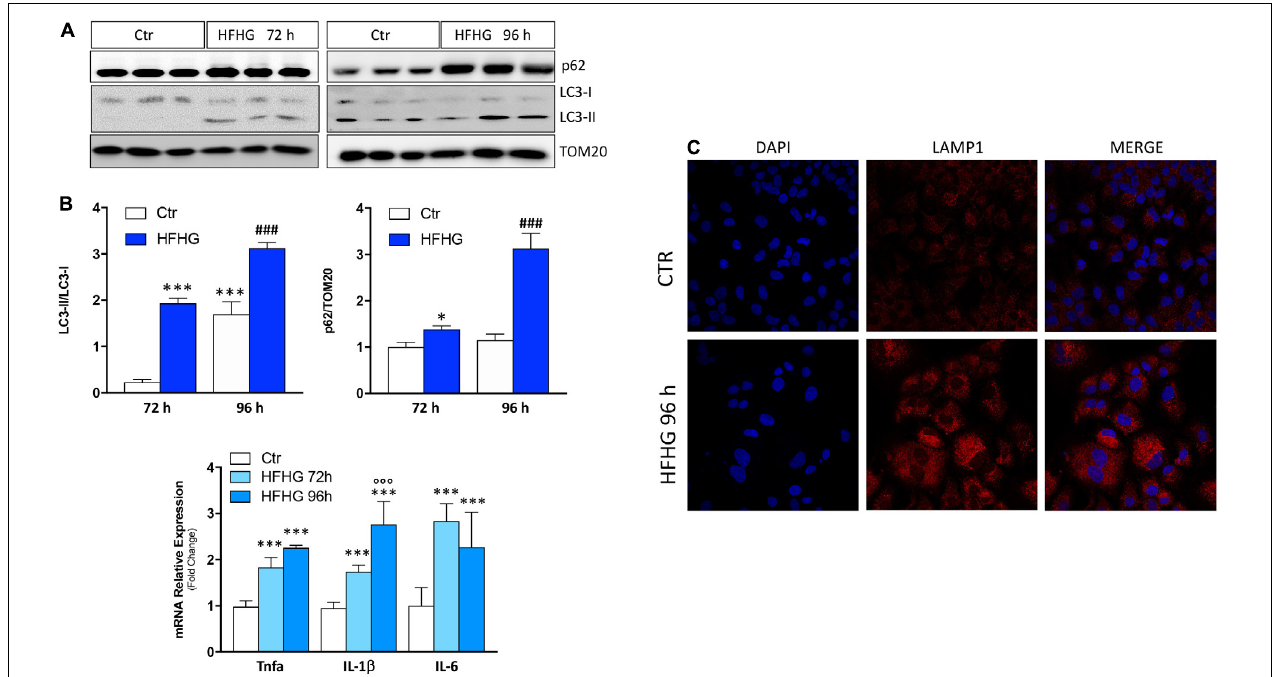
FIGURE 2 | Huh7 human cells treated with 400 µ M palmitate and 4.5 g/L glucose (HFHG) show accumulation of p62/SQSTM1 protein and increase of LC3-II/LC3-I protein ratio (A) as well as up-regulation of inflammatory cytokines (B) and lysosomal mass (C) after 72 and 96 h of treatment. TOM20 was used as loading control. Densitometric analyses of p62/SQSTM1 and LC3-II/LC3-I are shown in the bottom panel (A) . n = 3; *** p < 0.001, * p < 0.05 vs. Ctr; ◦◦◦ p < 0.001 vs. HFHG 72 h, ### p < 0.001 vs. Ctr 96 h.